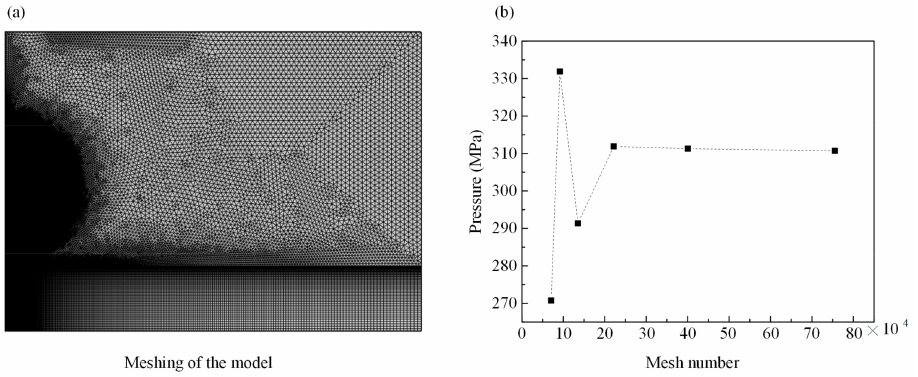
Figure 3. ( a ) Meshing of the model and ( b ) mesh independence check.